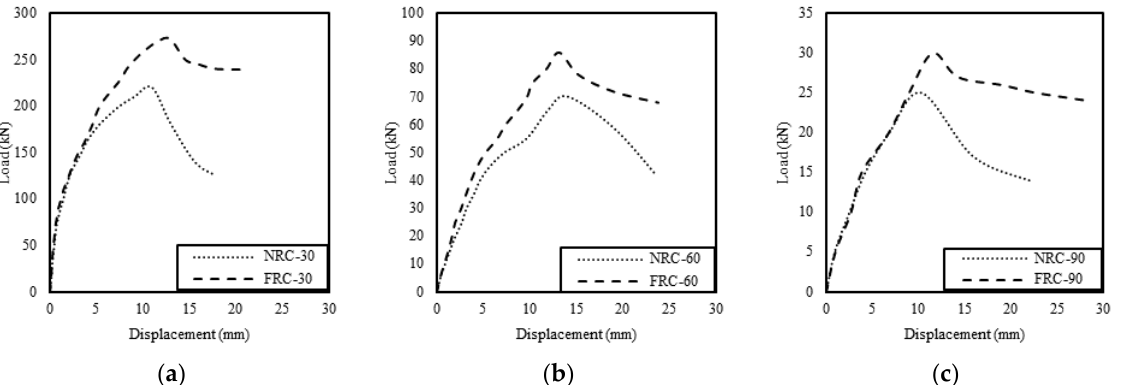
Figure 12. Load – vertical deflection of V-shaped columns with ( a ) 30°, ( b ) 60°, and ( c ) 90° angles. Figure 12. Load–vertical deflection of V-shaped columns with ( a ) 30 ◦ , ( b ) 60 ◦ , and ( c ) 90 ◦ angles.